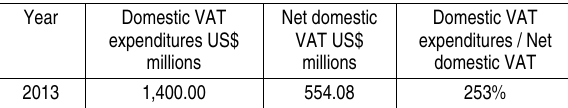
Table 3. Domestic VAT expenditures (zero rates and exemptions) versus collections